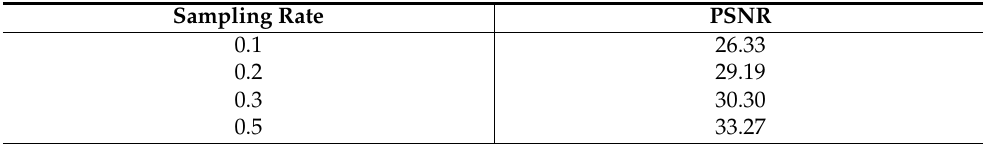
Table 3. Recognition rates of VGG16, ResNet50, and DenseNet121 for X (cid:48) CSNet (%).